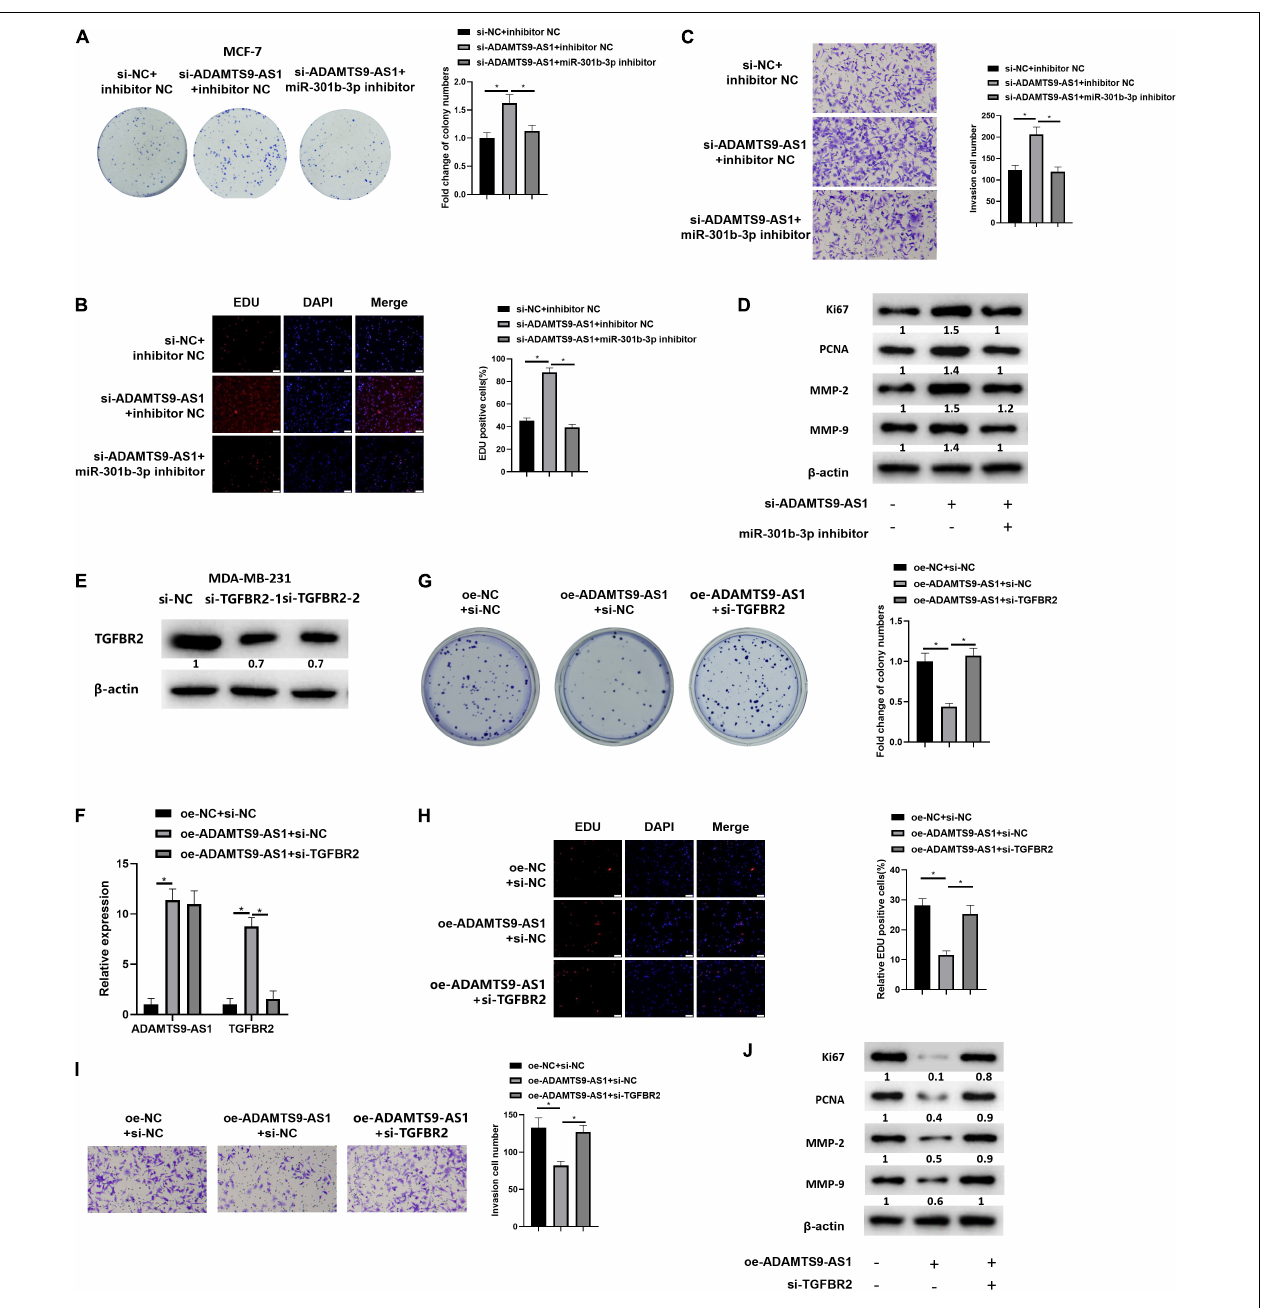
FIGURE 4 | ADAMTS9-AS1 promotes TGFBR2 through miR-301b-3p to inhibit breast cancer cell invasion and proliferation. (A) The proliferation of MCF-7 cells. (B) EdU assay used to detect MCF-7 cell proliferation (400 × ). (C) Invasion of MCF-7 cells (100 × ). (D) Levels of Ki67, PCNA, MMP-2 and MMP-9. (E) Level of TGFBR2 in si-NC, si-TGFBR2-1 and si-TGFBR2-2 groups. The silencing sequence with the highest silencing efficiency was named as si-TGFBR2. (F) ADAMTS9-AS1 and TGFBR2 expression in MDA-MB-231 cells. (G) Proliferation of MDA-MB-231. (H) Proliferation of MDA-MB-231 (400 × ). (I) Cancer cell invasion (100 × ). (J) Levels of Ki67, PCNA, MMP-2 and MMP-9. * p <